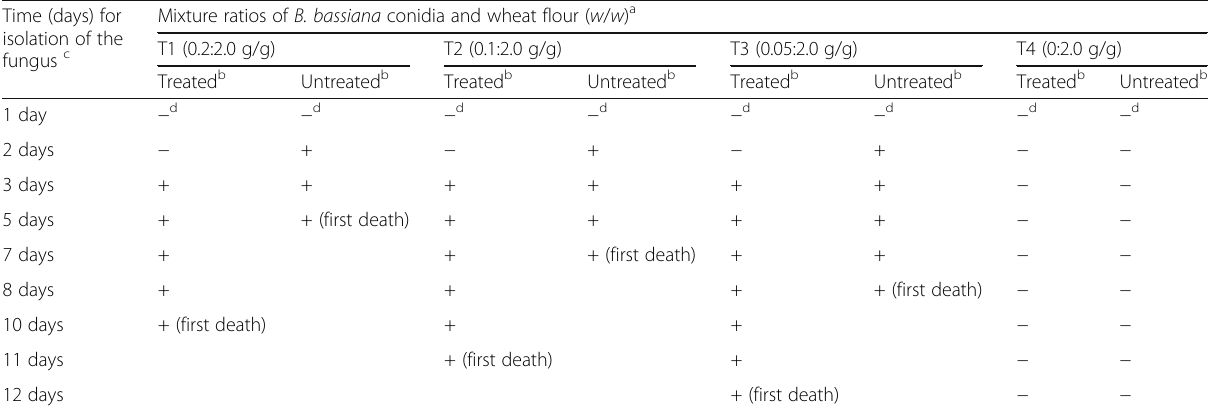
Table 2 Isolation of ingested fungus conidia (or mycelium developing from them) of Beauveria bassiana from infected adults of granary weevil, Sitophilus granarius , after feeding them on mixtures of B. bassiana conidia + wheat flour for 24 h then incubated after surface treatment with Merpan ® on healthy rice grains at 20 °C Time (days) for Mixture ratios of B. bassiana conidia and wheat flour ( w / w ) a isolation of the fungus c